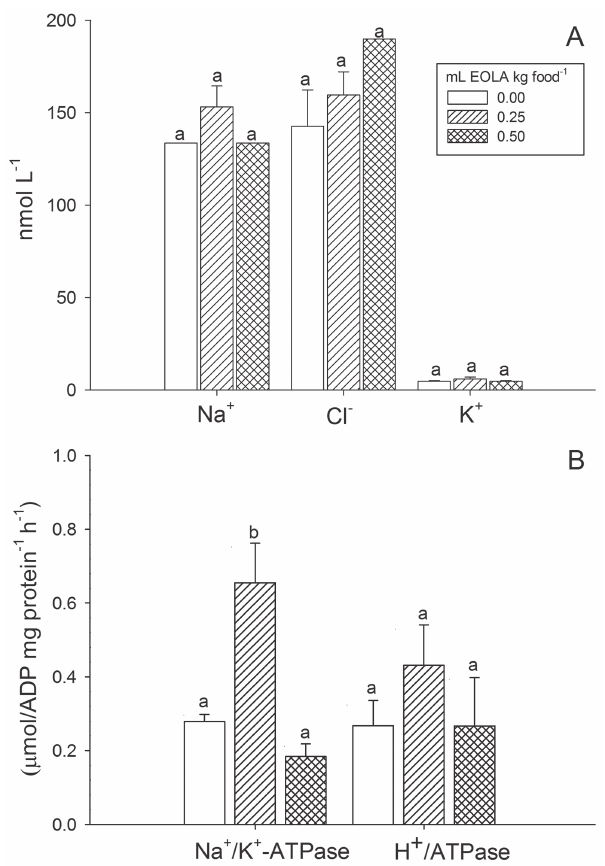
Fig. 3. Osmoregulatory parameters of Rhamdia quelen with different concentrations of dietary essential oil of Lippia alba (EOLA). A) plasma ion levels and B) gill Na + /K + -ATPase and H + /ATPase activities. Mean ± SEM. Different letters indicate significant differences (P < 0.05) between treatments.